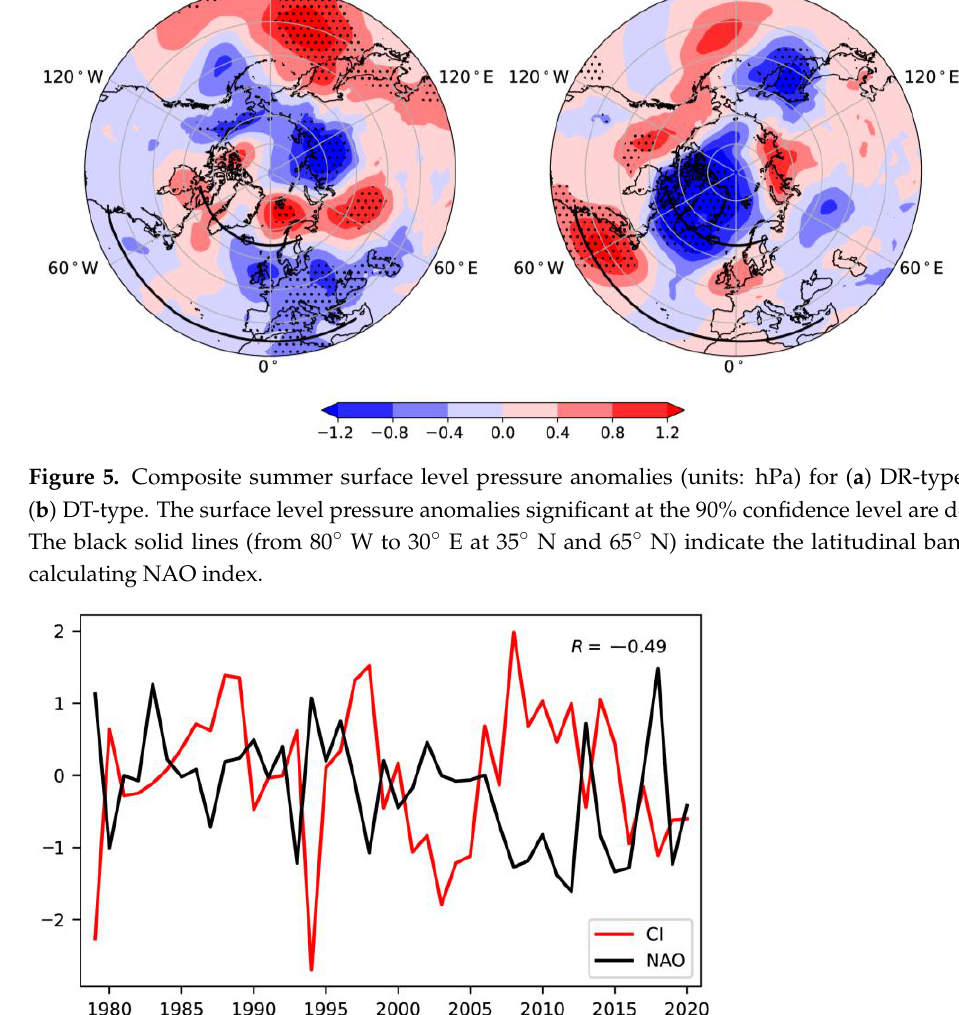
Figure 6. The normalized time series of the CI (red line) and the NAO index (black line) for 1979–2020, and their correlation coefficient (R) is − 0.49.